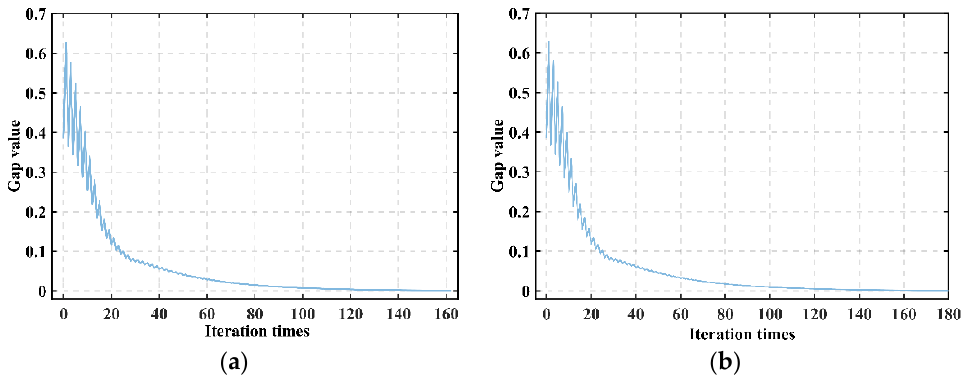
Figure 9. The convergence of solution approach. ( a ) PSL–SUE model. ( b ) MNL–SUE model.